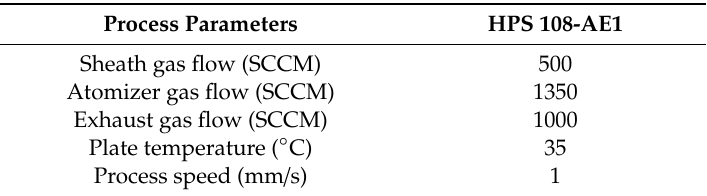
Table 1. Printing process for Ag